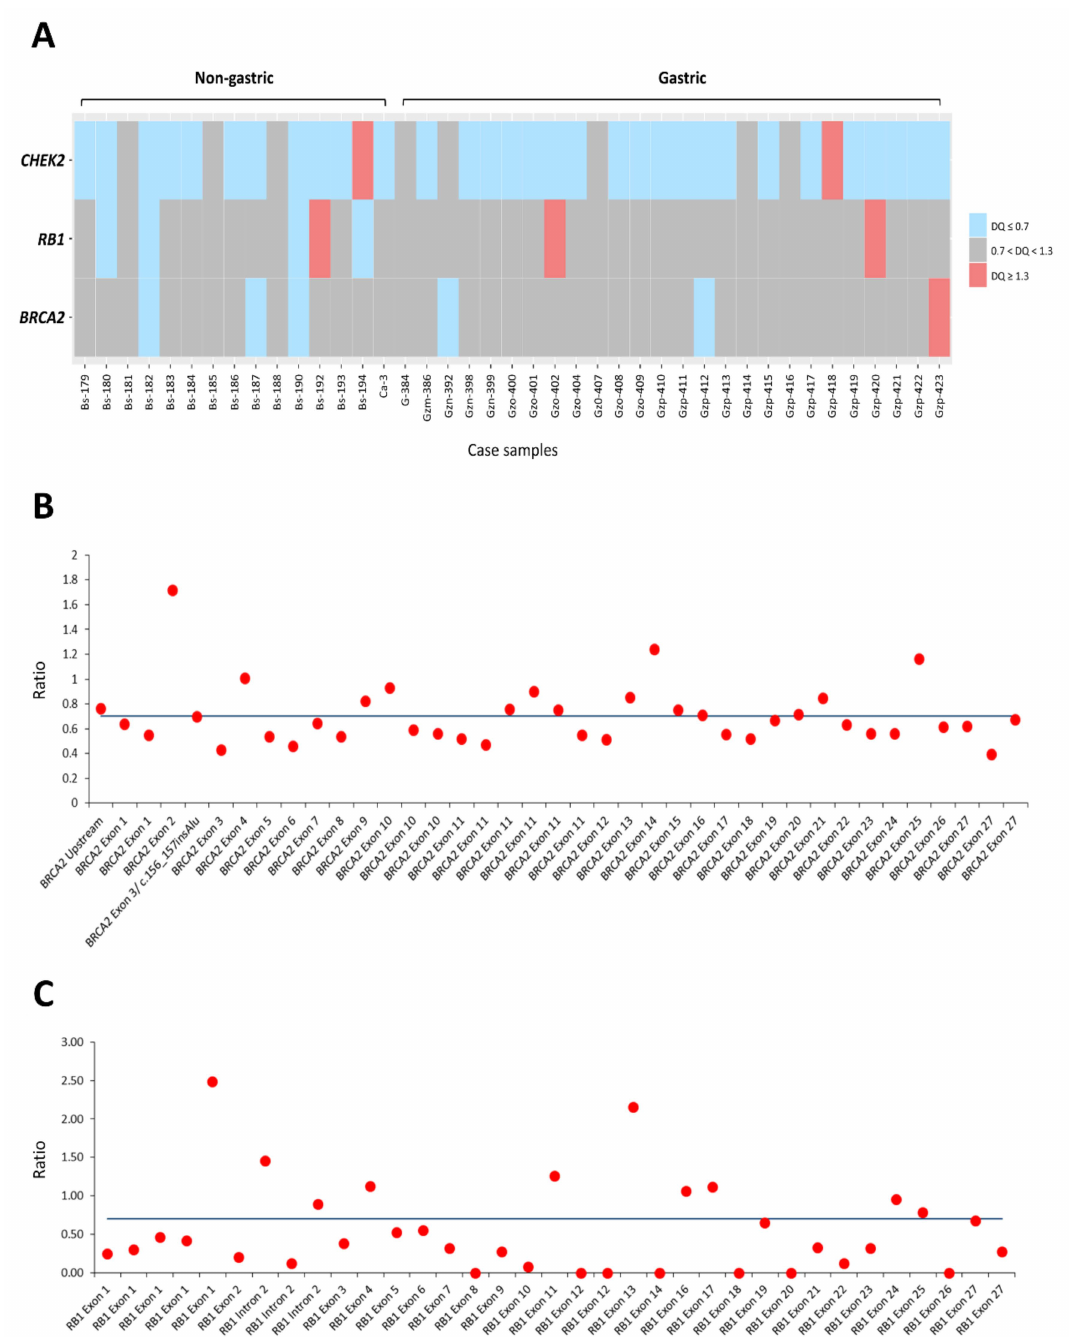
Figure 5. The copy number alterations of RB1 , BRCA2, and CHEK2 genes determined by MLPA assay. ( A ) The schematic illustration of MPLA assays shows frequent heterozygous deletions (HetDels) of CHEK2 in approximately three quarters of the 41 samples tested, without significant differences between gastric and non-gastric cases. HetDels of RB1 and BRCA2 were much rarer than CHEK2 - HetDel, while RB1 -HetDel, rather than BRCA2 -HetDel, has showed clear predominance in non-gastric GISTs. Losses of RB1 and BRCA2 trended toward co-deletion, but were rare events in two non-gastric cases. For each tumor tested, a gene was construed as harboring HetDel if it had a dosage quotient (DQ) of ≤ 0.7, and these are coded in pale blue, while normal ones are coded in grey with a DQ between >0.7 and <1.3, and duplicated ones are coded in red with a DQ ≥ 1.3. ( B , C ) In a representative case subjected to MPLA assays, across multiple exons, there were complex losses of BRCA2 ( B ) and RB1 ( C ) genes, whose DQ ratios ( Y -axis) dropped below the blue